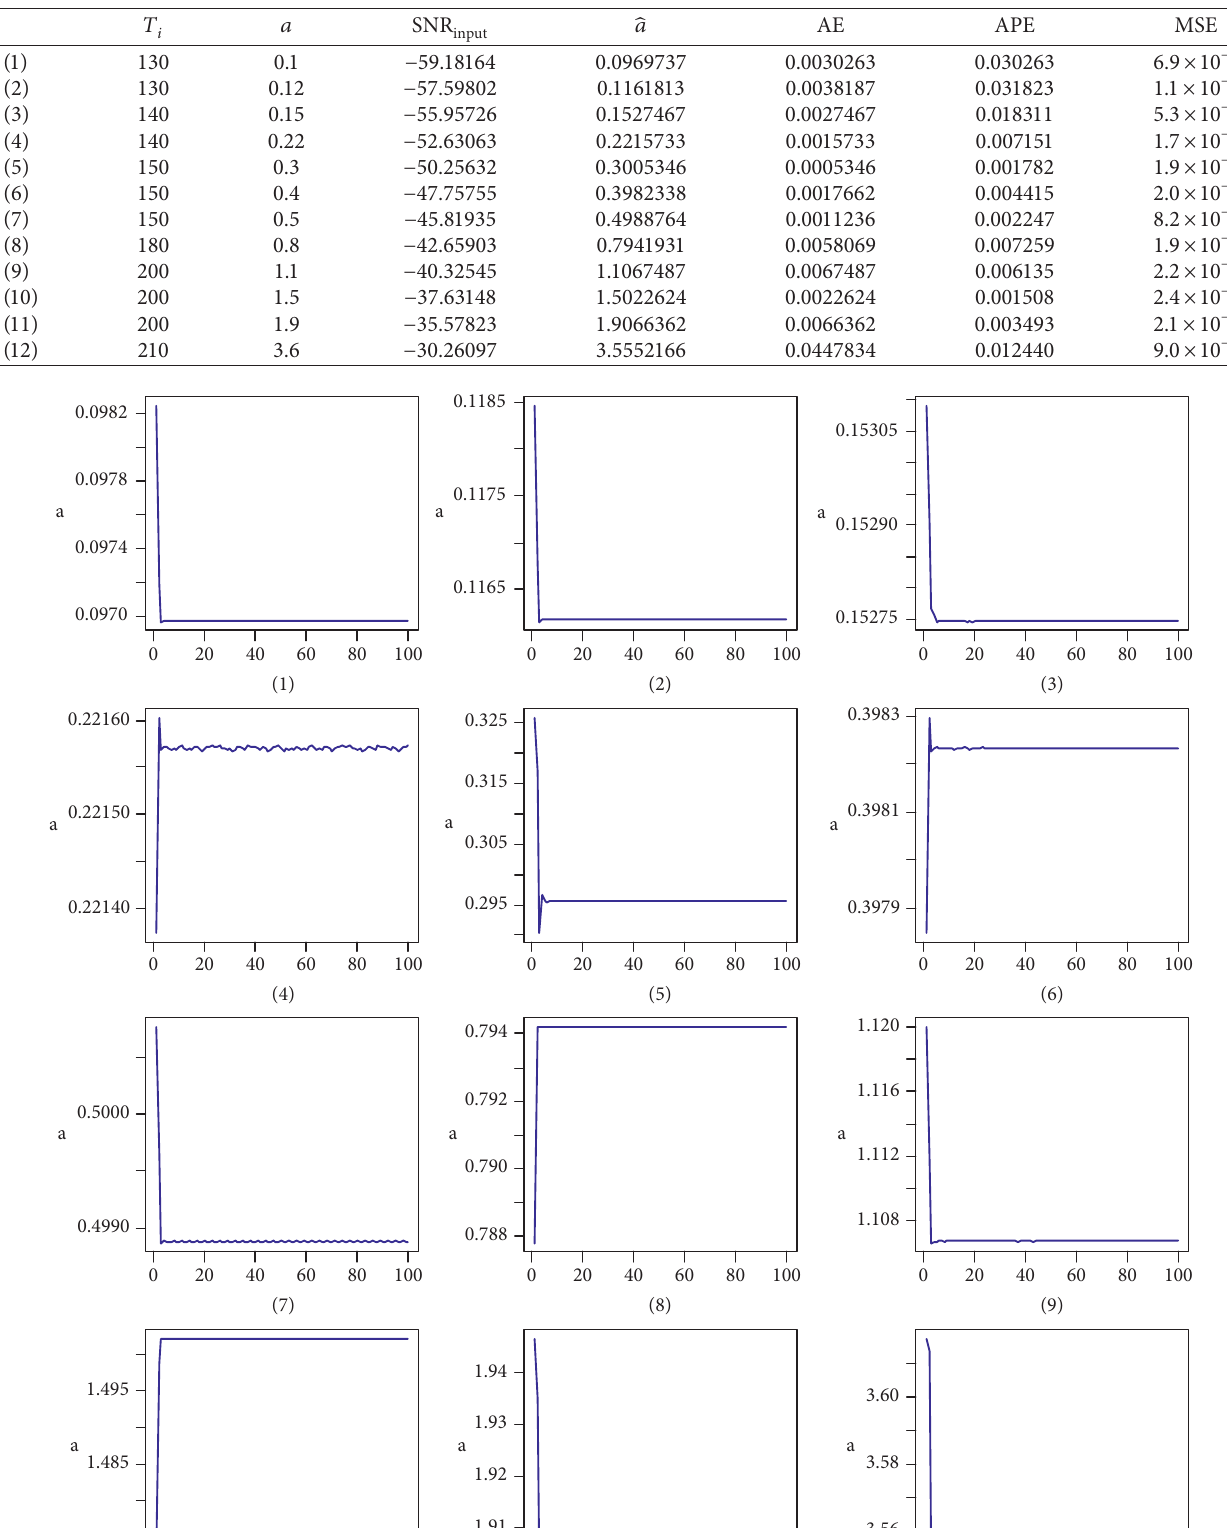
Table 1: Predicted value of a , AE, and APE with different SNRs.